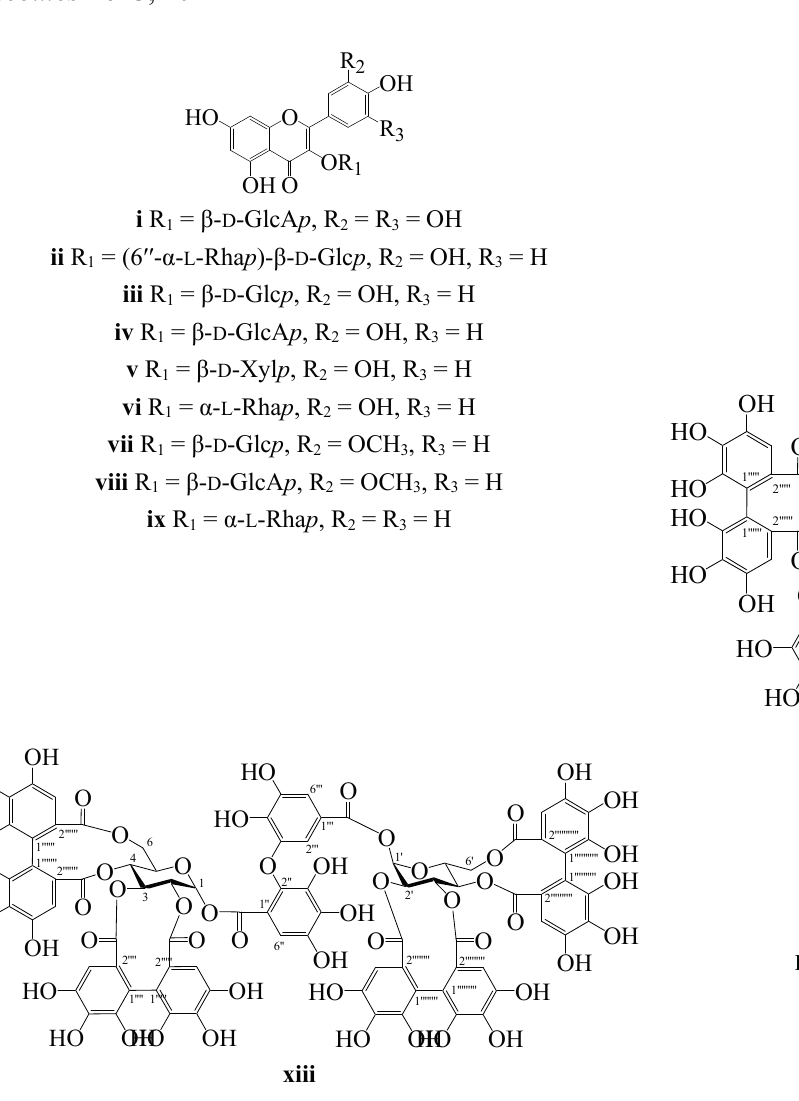
Figure 1. Chemical structures of compounds i – xvii isolated from P. anserina herb. β - D -Glcp— β - D -glucopyranose; β - D -GlcAp— β - D